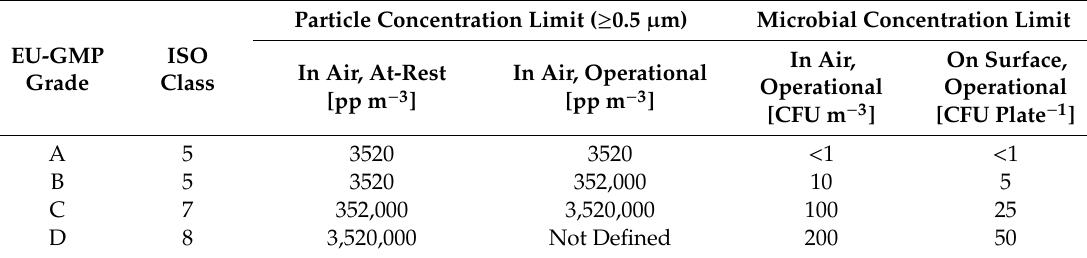
Table 3. Particle and microbial threshold limit for clean area during operation according to Annex 1, EU-GMP